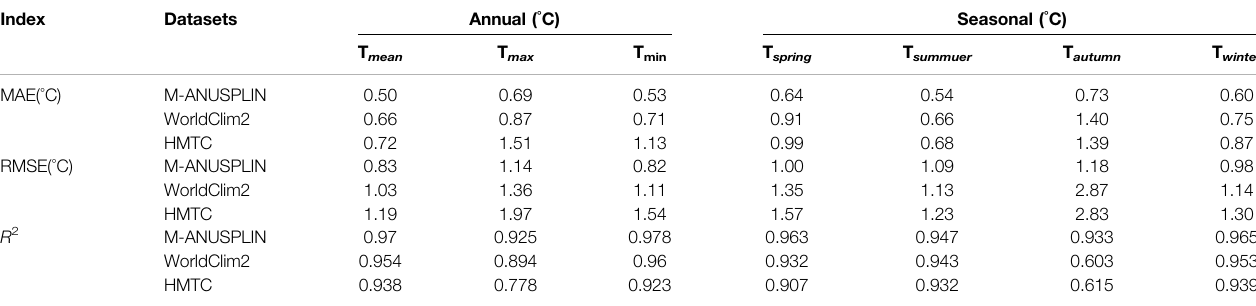
TABLE 5 | Comparisons of annual and seasonal climatology indices among different datasets.